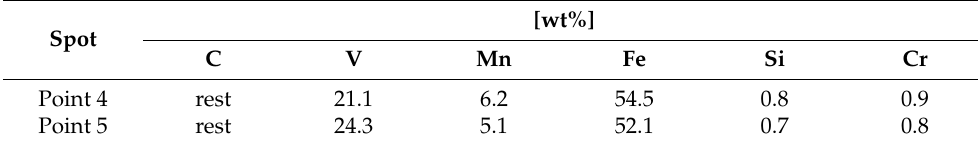
Table 5. Sample chemical compositions of the visible precipitates (Figure 8). Spot